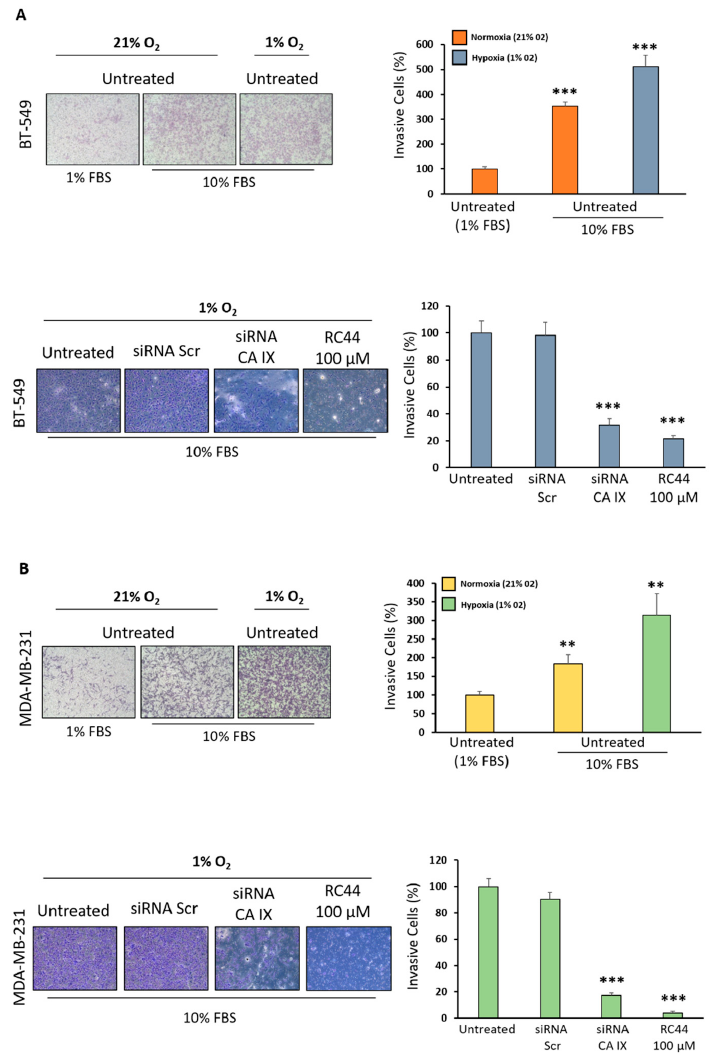
Figure 6. Blocking CA IX inhibits TNBC invasiveness. Boyden chamber coated with Matrigel to mimic ECM was used for cell invasion assay. BT-549 ( A ) and MDA-MB-231 ( B ) were grown in normoxia (21% O 2 ) or hypoxia (1% O 2 ) conditions and their invasion ability was analyzed. Medium containing 1% FBS or 10% FBS was added to the lower chamber as chemoattractant. The results are expressed as the percentage of invasive cells considering the untreated control sample (1% FBS) as 100%. TNBC cells grown in 1% O 2 were transfected with siRNA CA IX (100 nM) and siRNA Scr (100 nM) or treated with RC44 (100 µ M) and seeded in the upper chamber. Medium containing 10% FBS was added to the lower chamber as chemoattractant. The results are expressed as the percentage of invasive cells considering the untreated control sample (10% FBS) as 100%. Bars depict mean ± SD of three independent experiments. *** p < 0.0001; ** p <